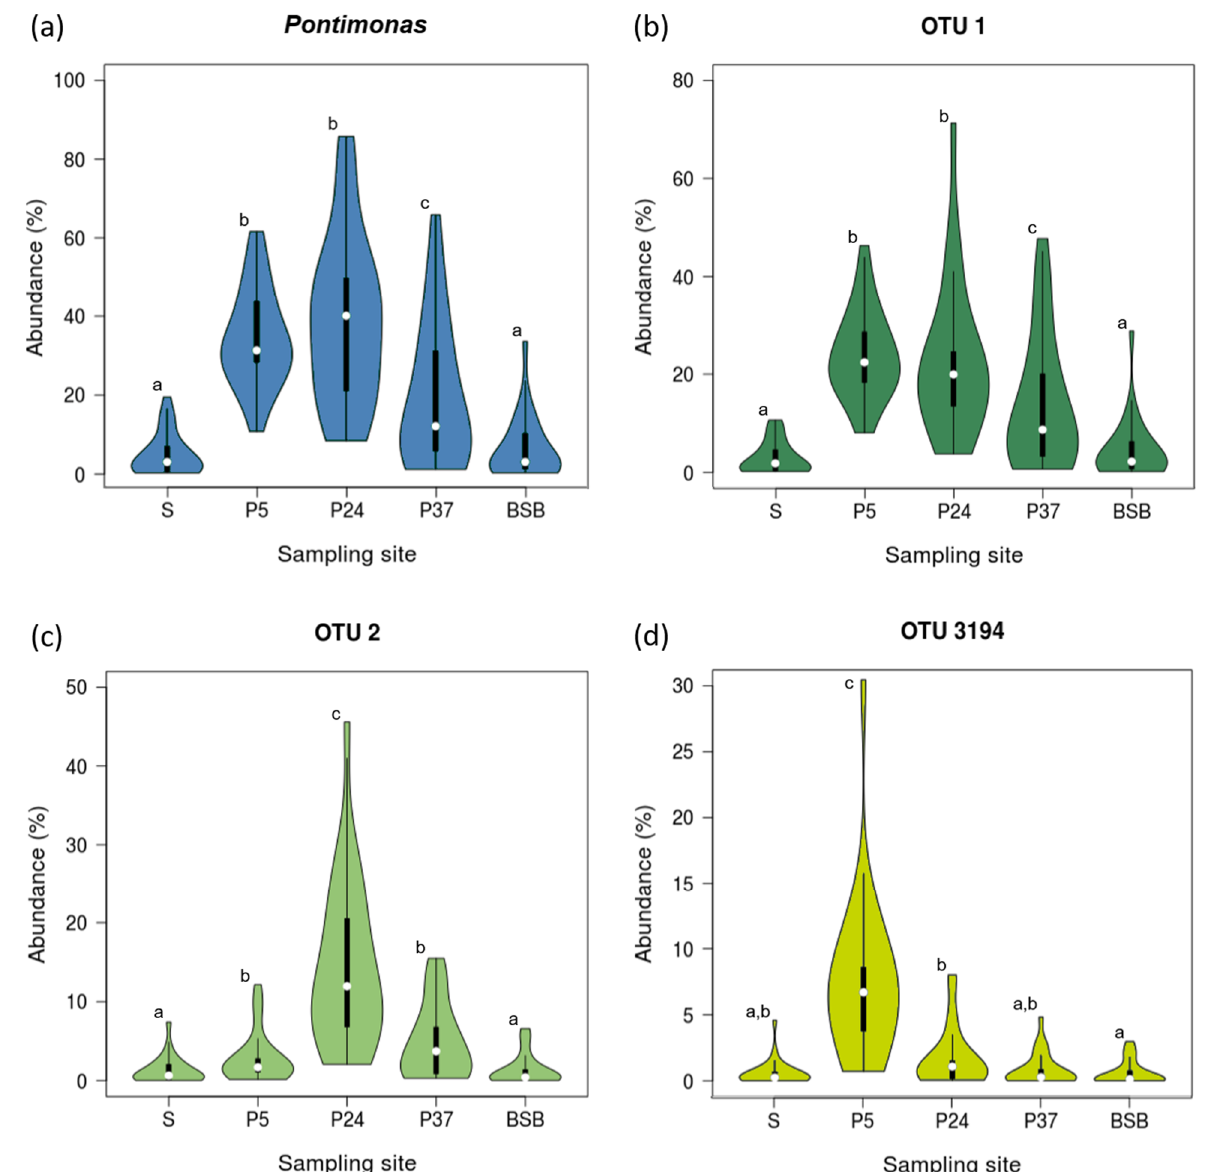
Figure 2. Violin plots showing the abundance variation of Pontimonas ( a ) and its most abundant OTUs ( b – d ) among the ST sampling sites in the period May 2012–April 2014. The same superscript letters indicate no significant differences between the mean values of different groups (Kruskal–Wallis followed by Kolmogorov–Smirnov post hoc test).